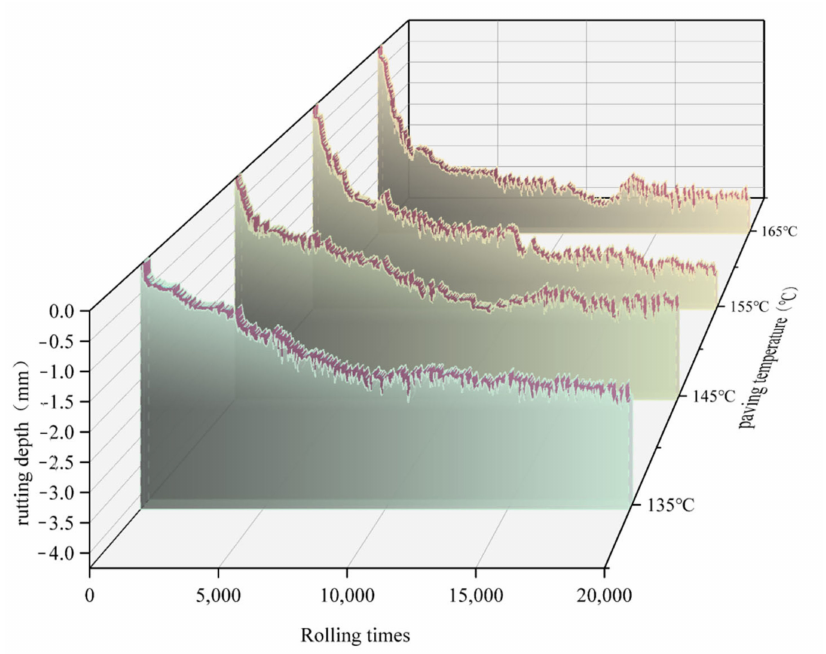
Figure 11. Results of the HWT